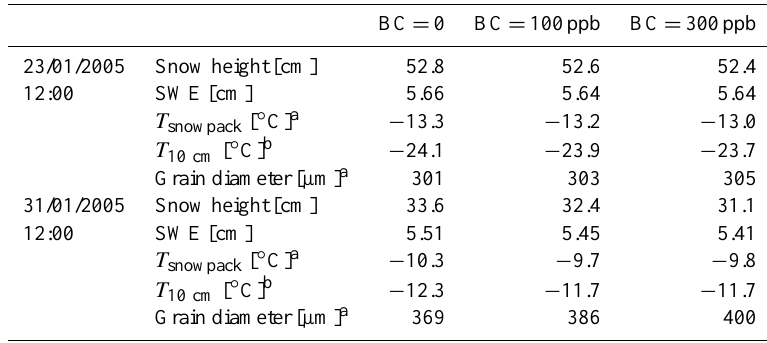
Table 1. Snowpack properties for 23 and 31 January 2005, simulated with the upgraded model including radiative transfer and with different BC concentrations.